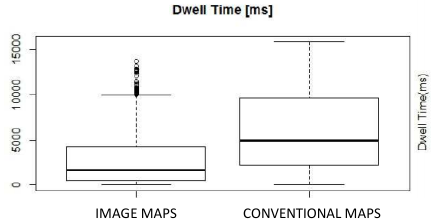
Figure 7. Dwell time boxplot – image maps (left) and conventional maps